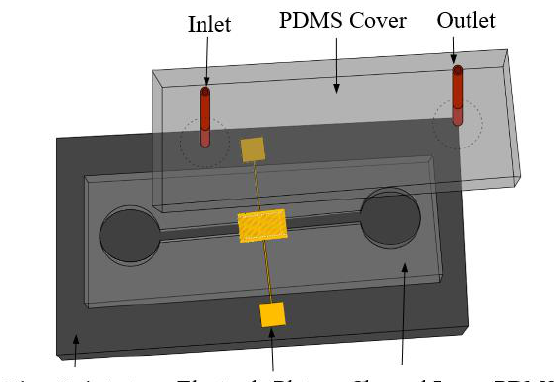
Figure 1. Schematic of microfluidic chip.